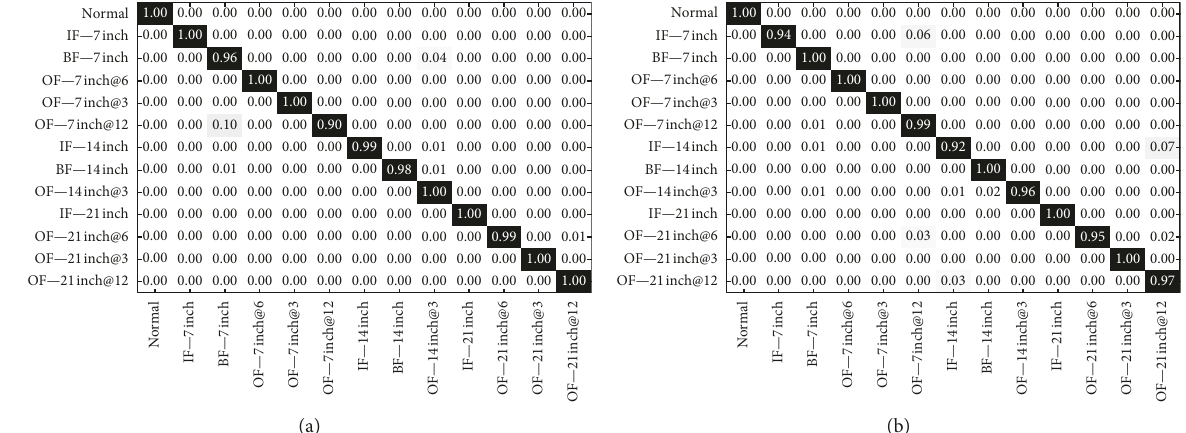
Figure 10: Confusion matrix for generalization experiments. (a) 2 hp results. (b) 3 hp